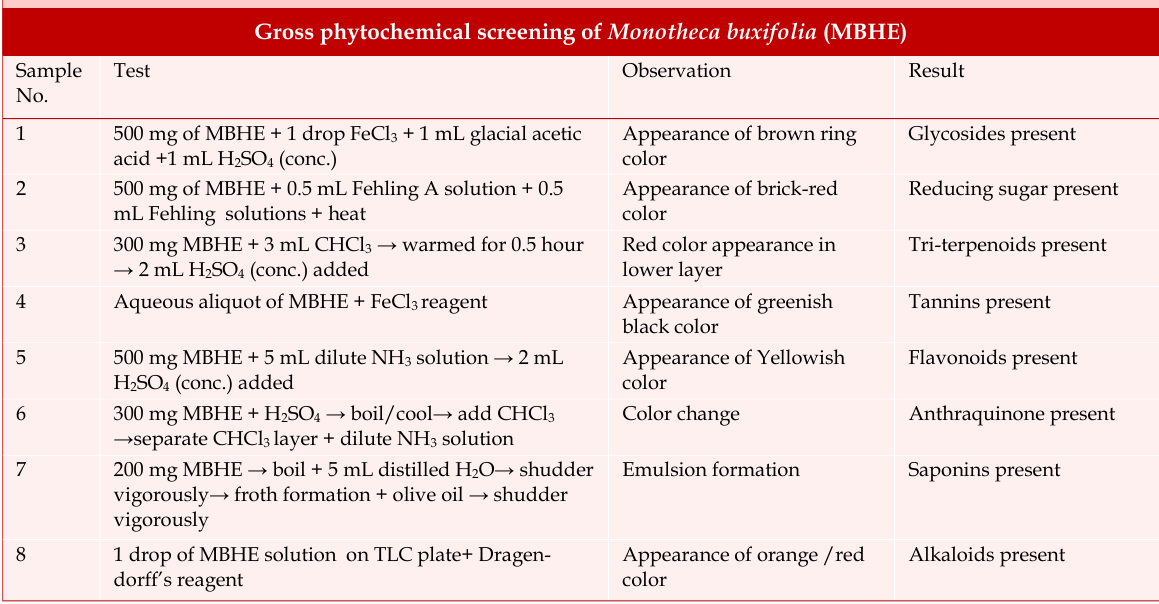
Gross phytochemical screening of Monotheca buxifolia (MBHE) Sample